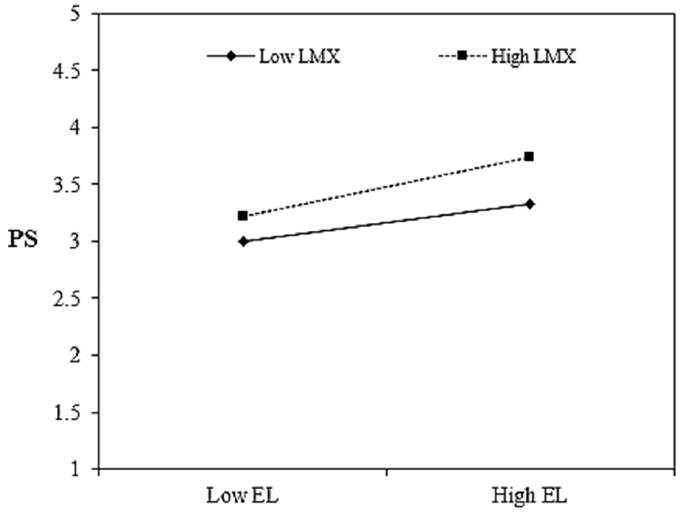
Figure 3. 1st stage interaction. Note: EL = ethical leadership, LMX = leader–member exchange, PS = psychological safety, VB = voice behavior.